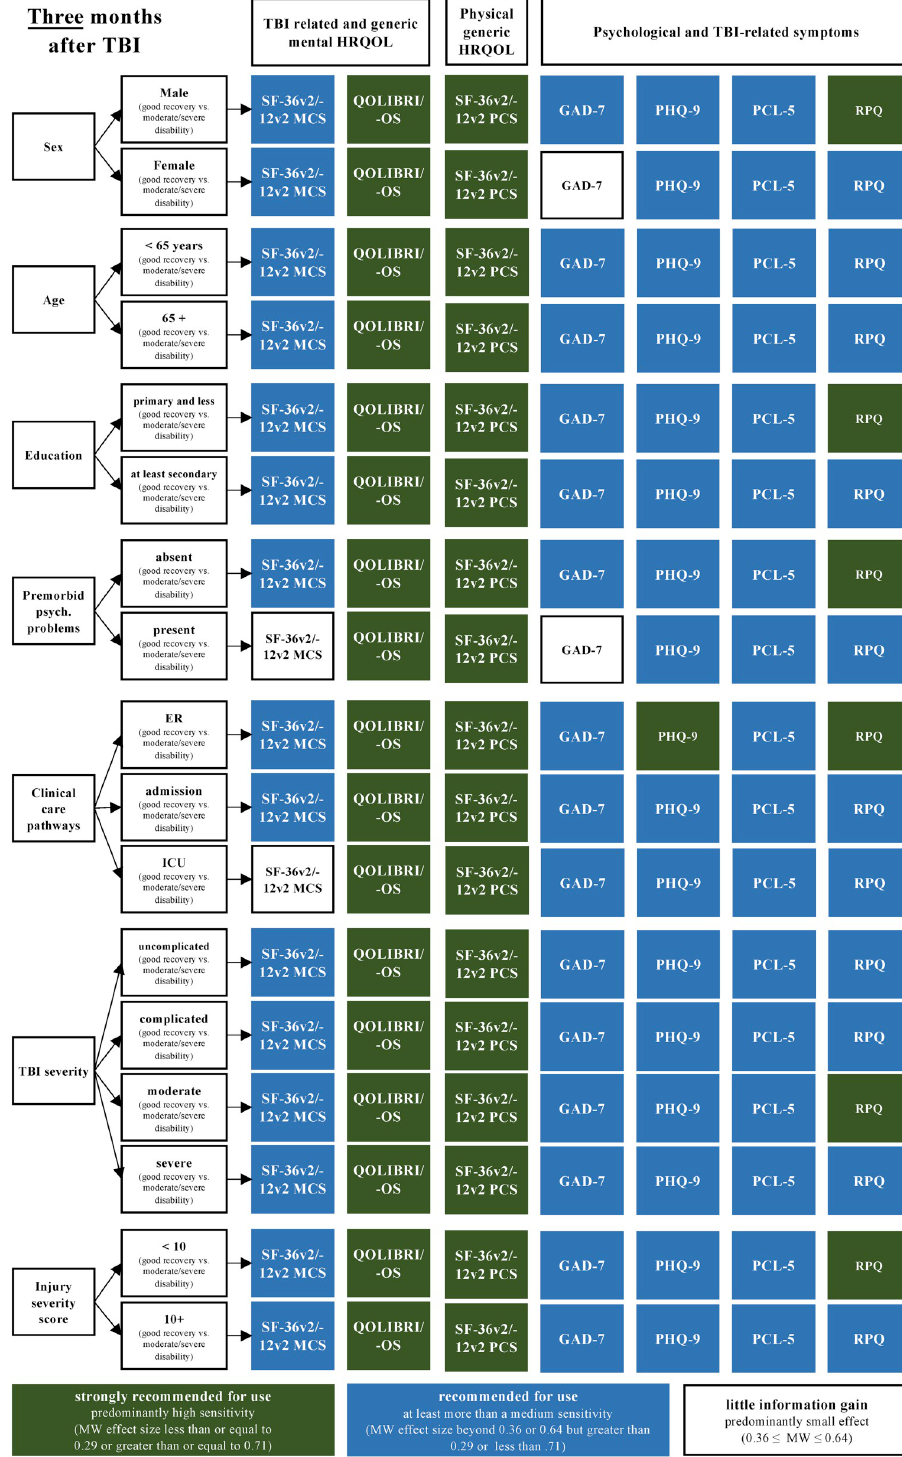
Fig 4. PROMs recommended for use with respect to different sociodemographic, premorbid, and injury-related patient groups and recovery statuses (i.e., GOSE/-Q as reference) at three months after TBI based on the MW effect sizes. Numbers are documented in S7 Table (data as available) and in S8 Table (completers).